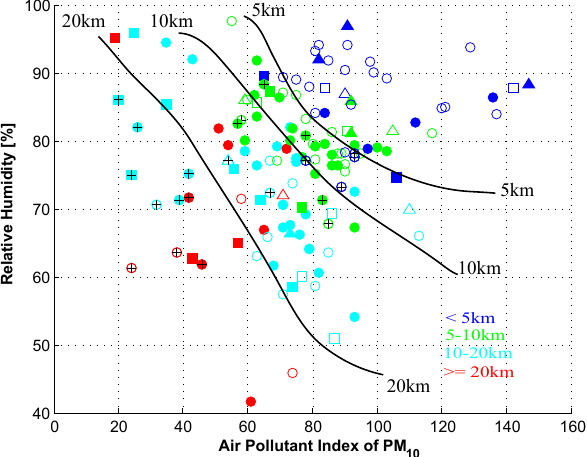
Fig. 8. Daily mean visibility distribution in relation to RH, PM 10 in- dex, wind speed, and wind direction for August from 2003 and 2008 in Beijing. Blue symbol represents visibility lower than 5km, green symbol represents visibility lower than 10km and no less than 5km, cyan symbol represents visibility lower than 20km and no less than 10km, and red symbol represents visibility no less than 20km. The symbols with “+” represent observation in 2008. Triangle repre- sents wind speed lower than 1.5ms − 1 , circle represents wind speed greater than 1.5ms − 1 and lower than 3ms − 1 , and square repre- sents wind speed greater than 3ms − 1 . Hollow symbols represent wind directions of south, southeast, east, and southwest. Solid sym- bols represent wind directions of northeast, north, northwest and west. The black solid lines denote the visibility contour of 5km, 10km and 20km.